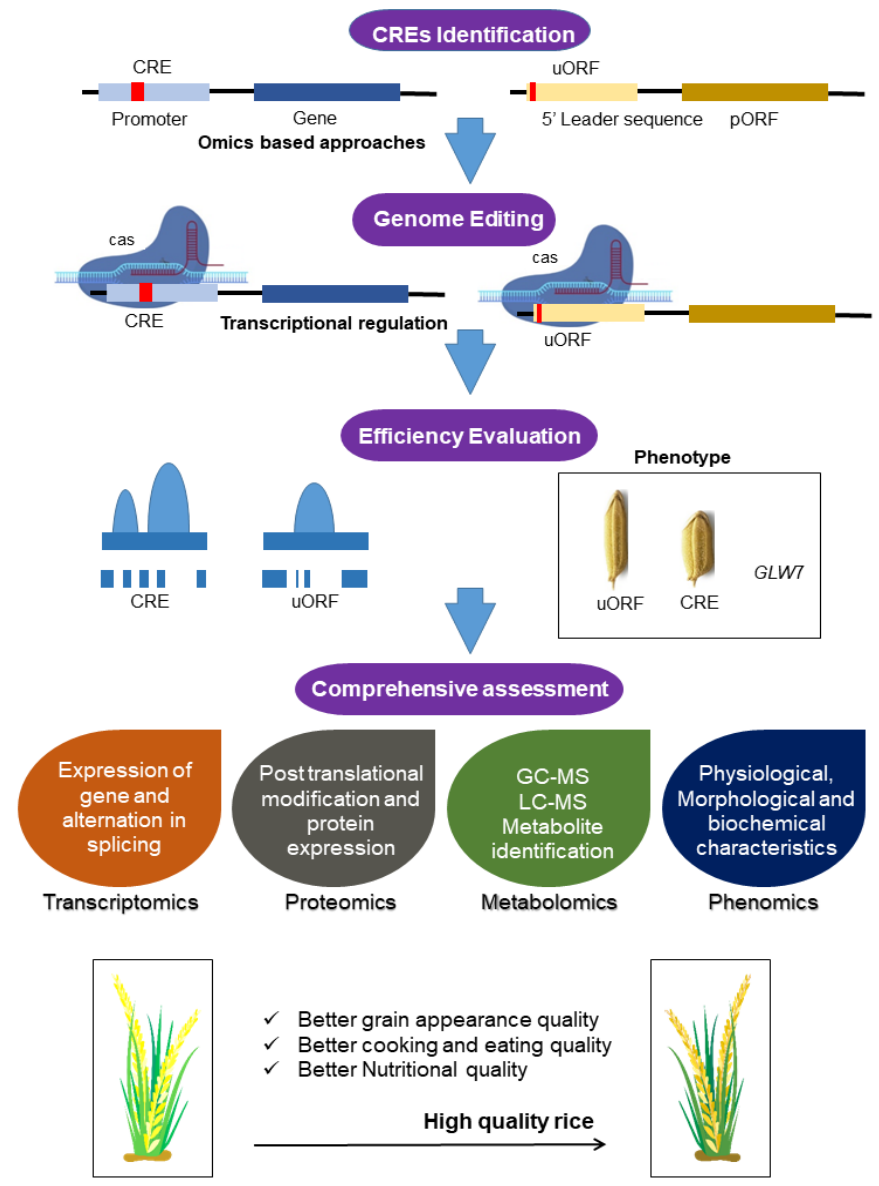
Figure 2. Flowchart demonstrating the use of genome editing techniques to produce high-quality rice grains.